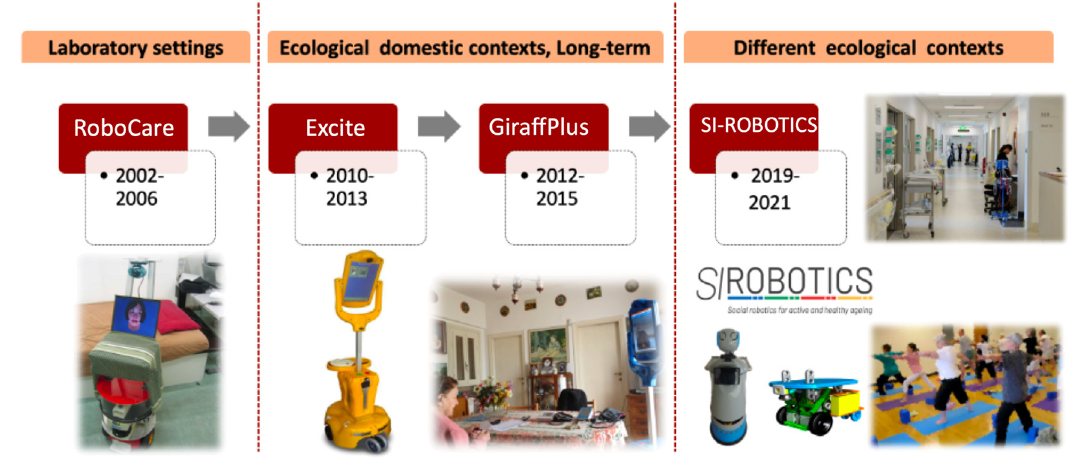
Figure 1: A summary timeline showing the integration of AI and robotics in our research